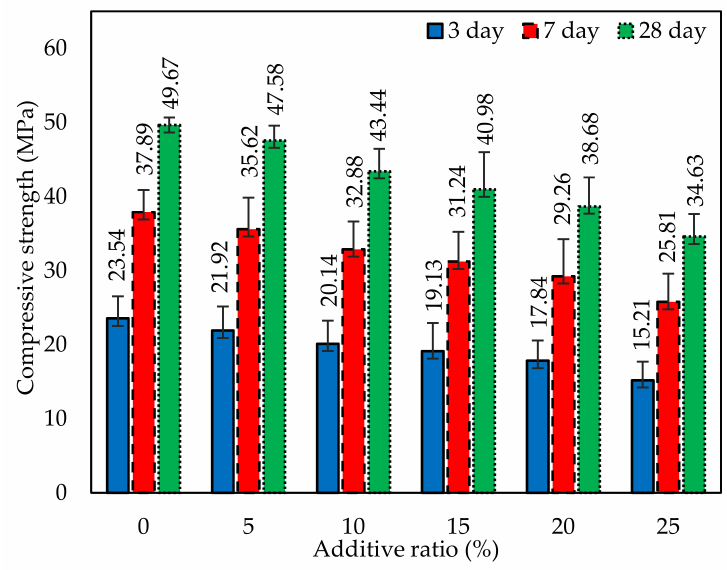
Figure 11. The compressive strength test results of cementitious composite